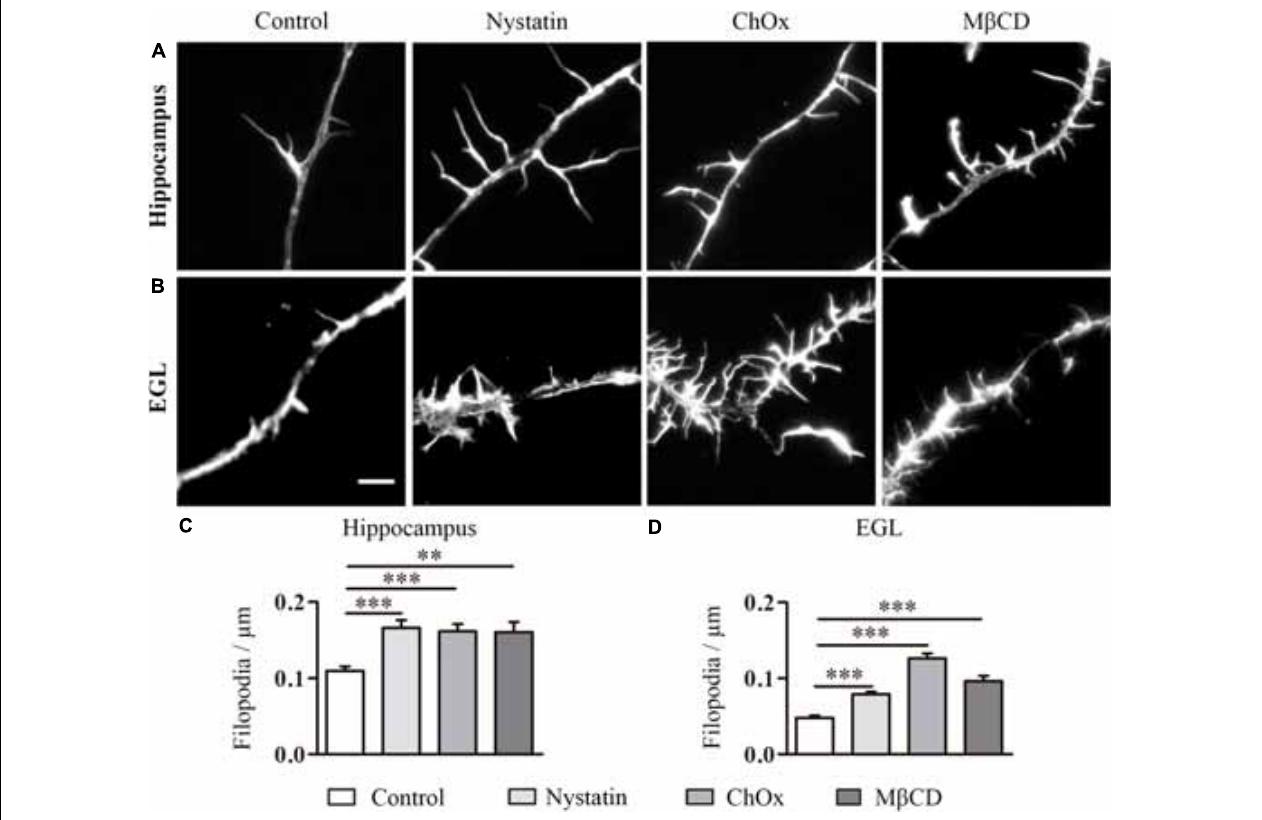
FIGURE 2 | Cholesterol depletion increases filopodium-like structures in hippocampal neurons and EGL neurons. Examples of hippocampal (A) and EGL (B) filopodium-like structures in axons treated with control culture media, 2.5 µ g/ml Nystatin, 2U ChOx, and 0.5 mM M β CD and stained with phalloidin. The density of filopodium-like structures was measured in discrete segments of axons in three independent experiments. Data represent means ± SEM (C,D) . N = 150–250 neurons in each condition (One-way ANOVA, Dunnett’s Multiple comparison test ∗∗ p < 0.01, ∗∗∗ p < 0.0001). Scale bar 5 µ